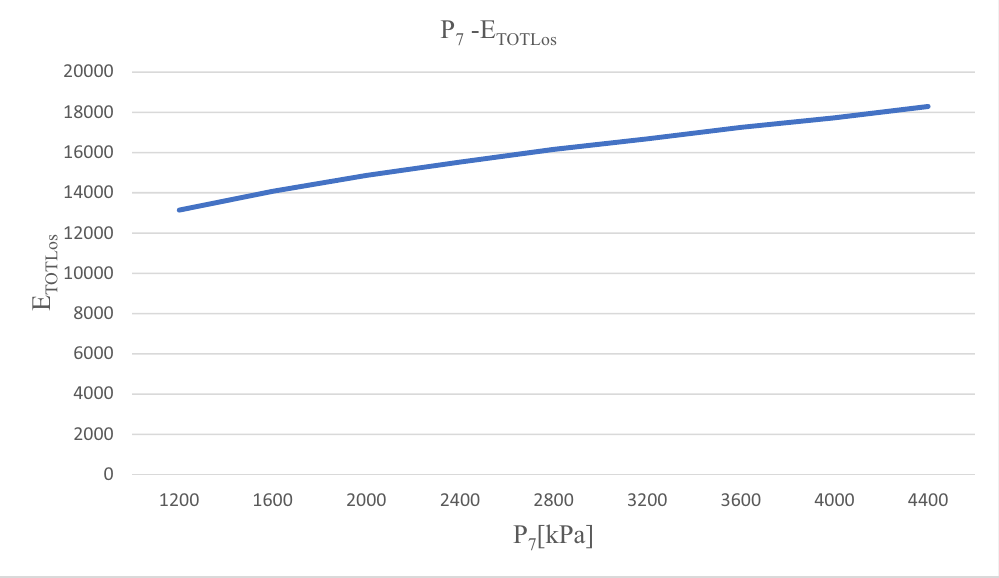
Figure 11: Exergy loss curve of the entire cycle obtained for di ff erent outlet pressures at which the second - stage compressor of the vapor compression three - stage cascade cryogenic cycle can operate.